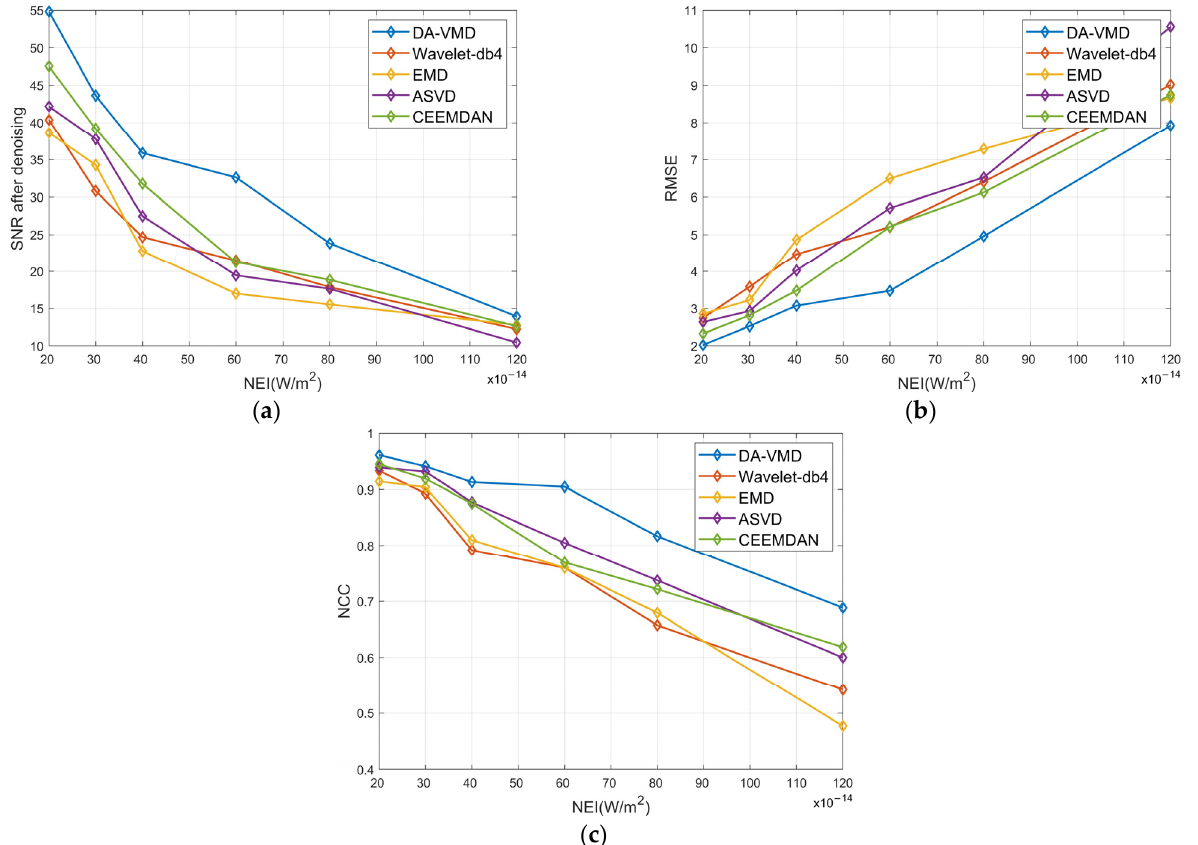
Figure 13. Denoising performance with different NEIs of the noisy radiation intensity signal of the cone-cylinder; ( a ) SNR; ( b ) RMSE; ( c )